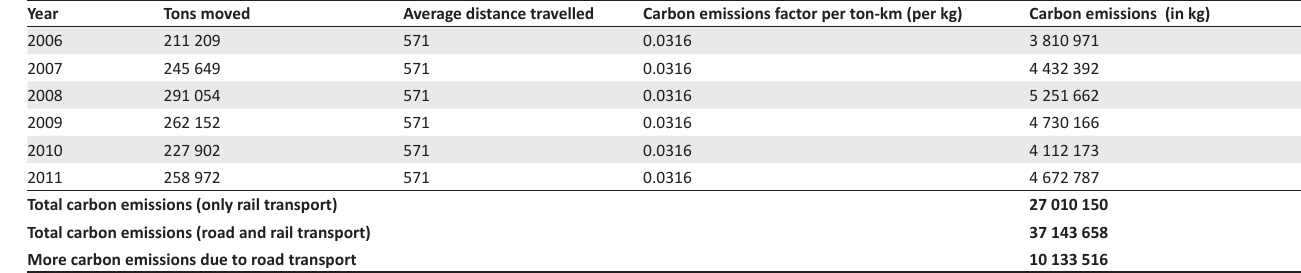
TABLE 7: Carbon emissions if all freight was moved by